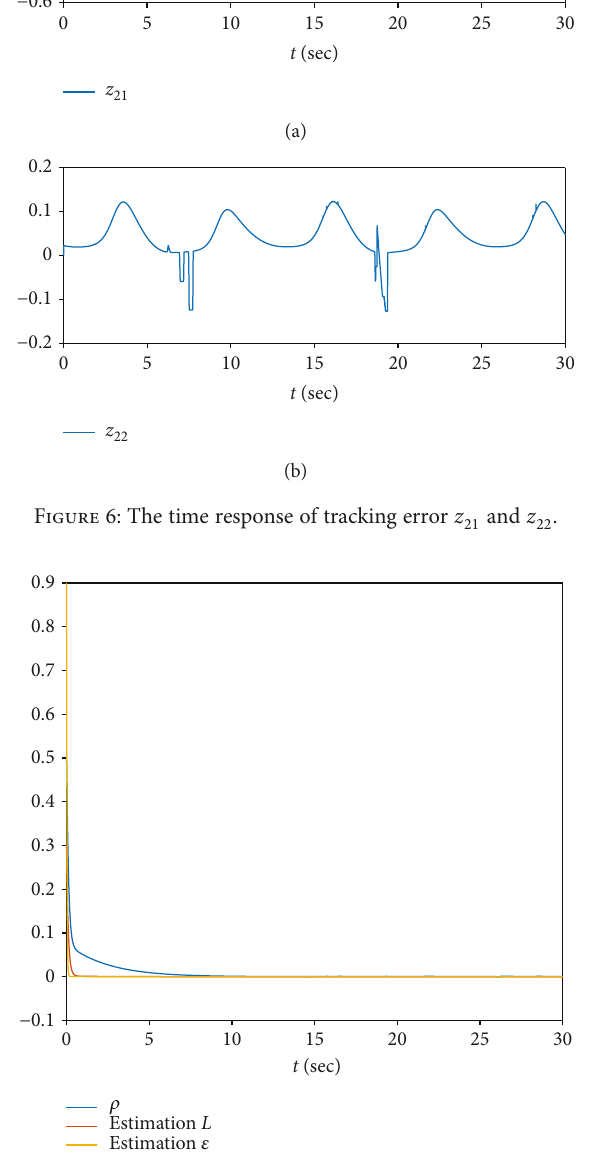
Figure 7: Thetimeresponseof parametersincontroller(18)